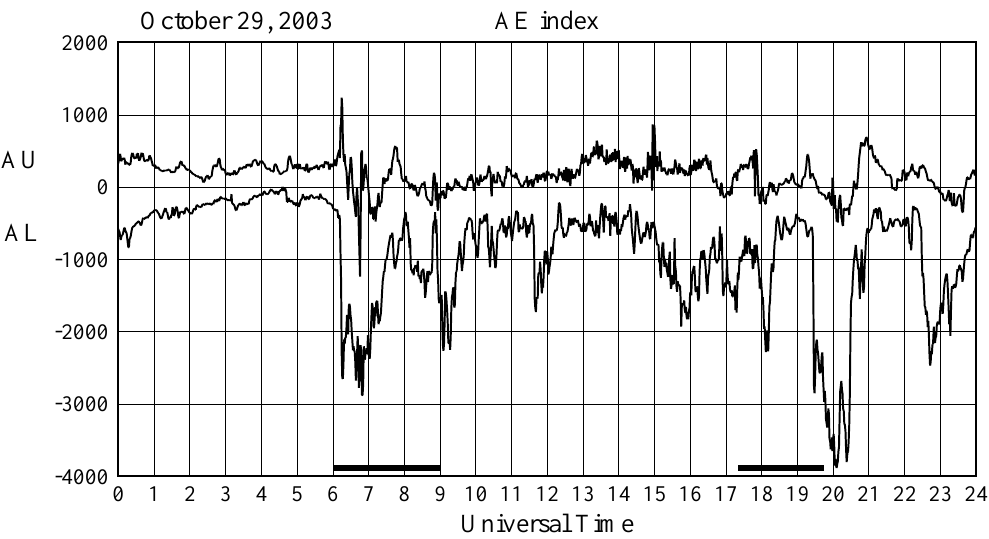
Fig. 5. This figure presents the AE index corresponding to 29 October 2003. The lines near the bottom indicate the times when TEC perturbations were detected by our analysis